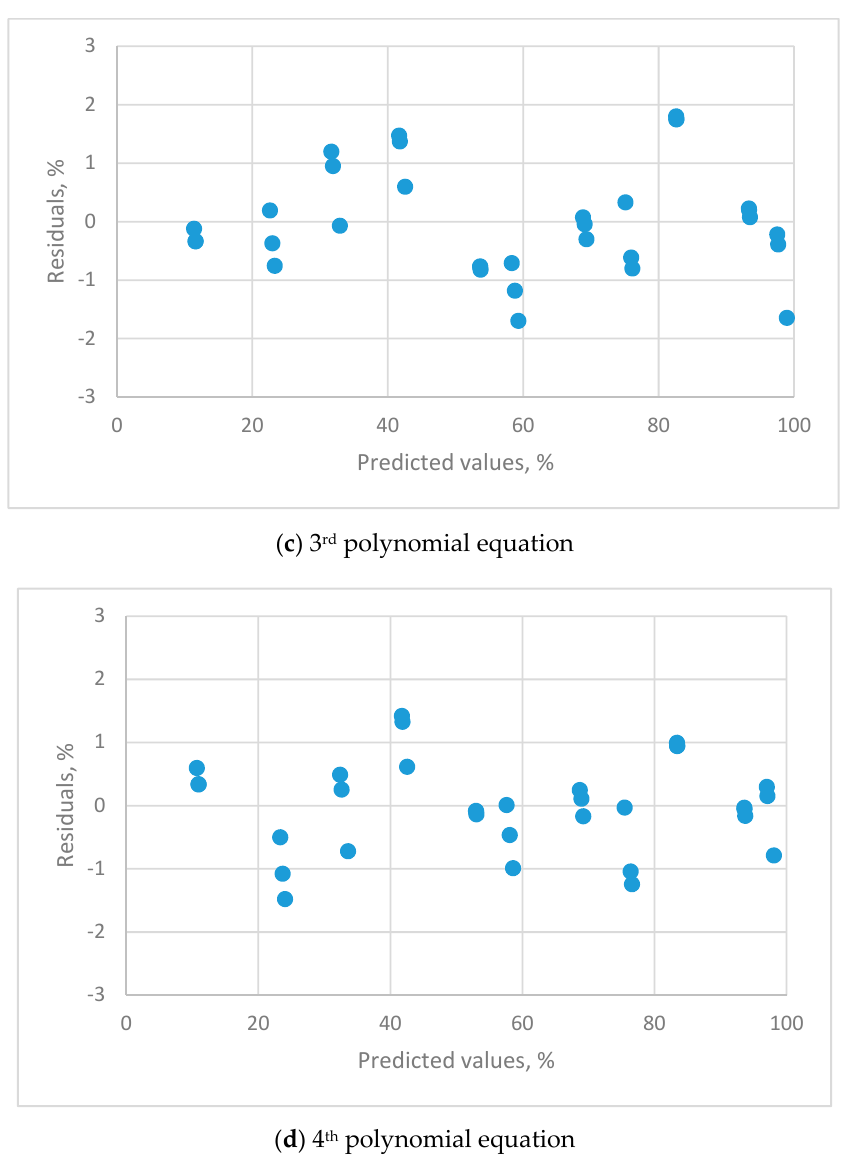
Figure 3. The residual plots for the calibration equations for different orders of polynomial equations for THT-B121 resistive humidity sensor using 11 saturated salt solutions (LiCl, CH 3 COOK, MgCl 2 , K 2 CO 3 , Mg(NO 3 ) 2 , NaBr, KI, NaCl, KCl, KNO 3 and K 2 SO 4 ).